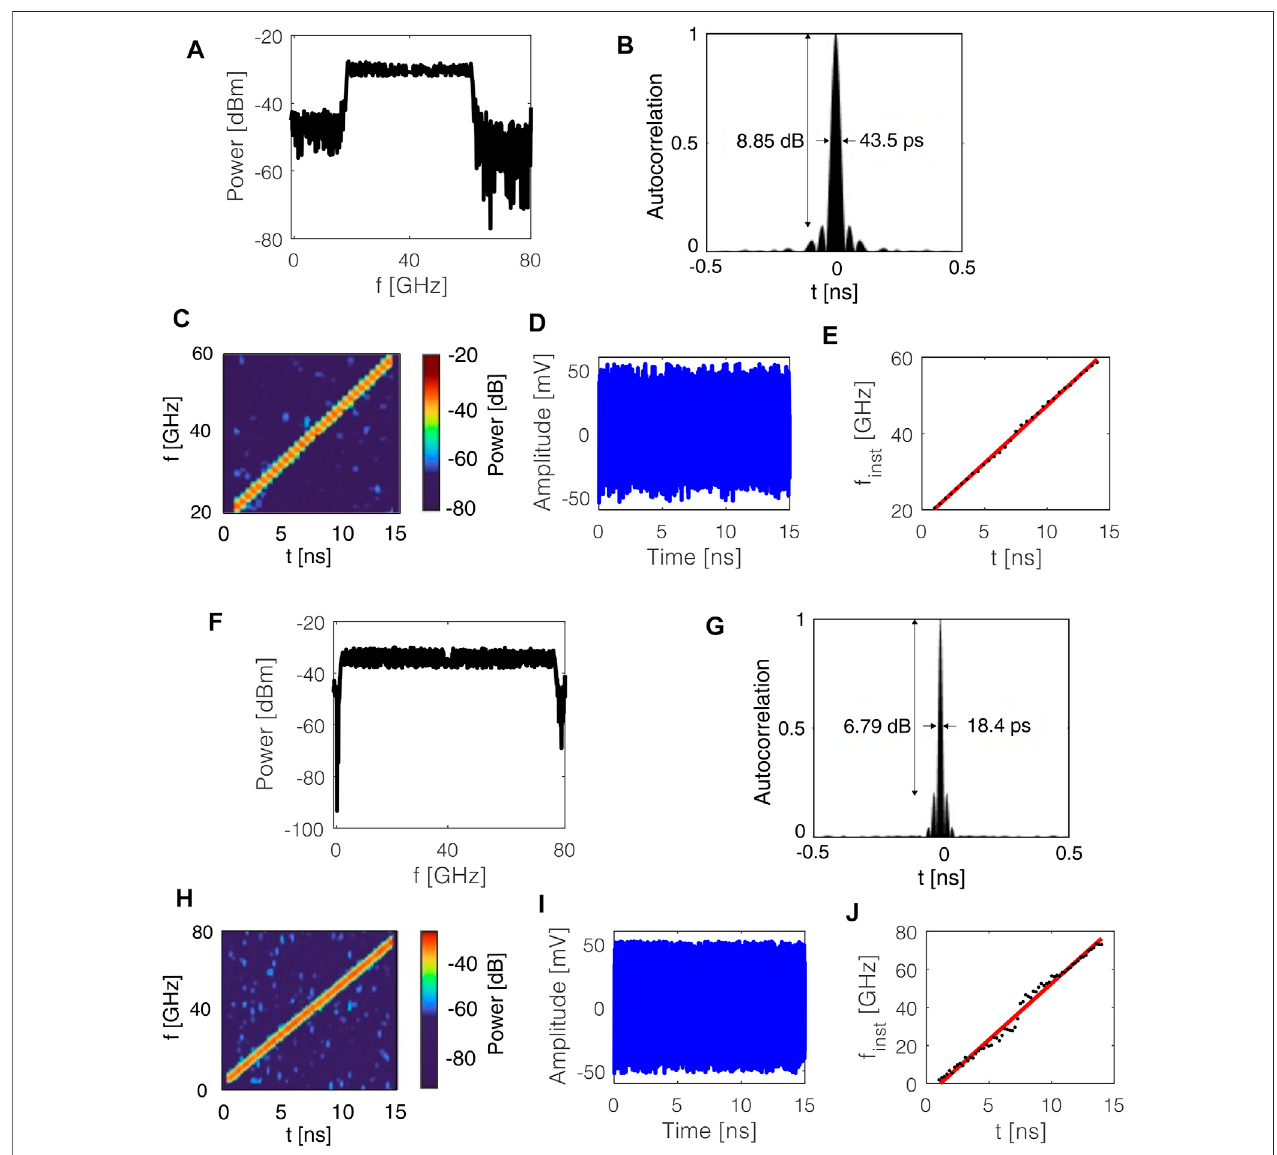
FIGURE 9 | LCMW generator output spectrum, its autocorrelation function, power spectral density vs. frequency and time, time-domain waveform, and instantaneous frequency f inst vs. time, for M = 40, N = 9 (A – E) and M = 40, N = 18 (F – I)